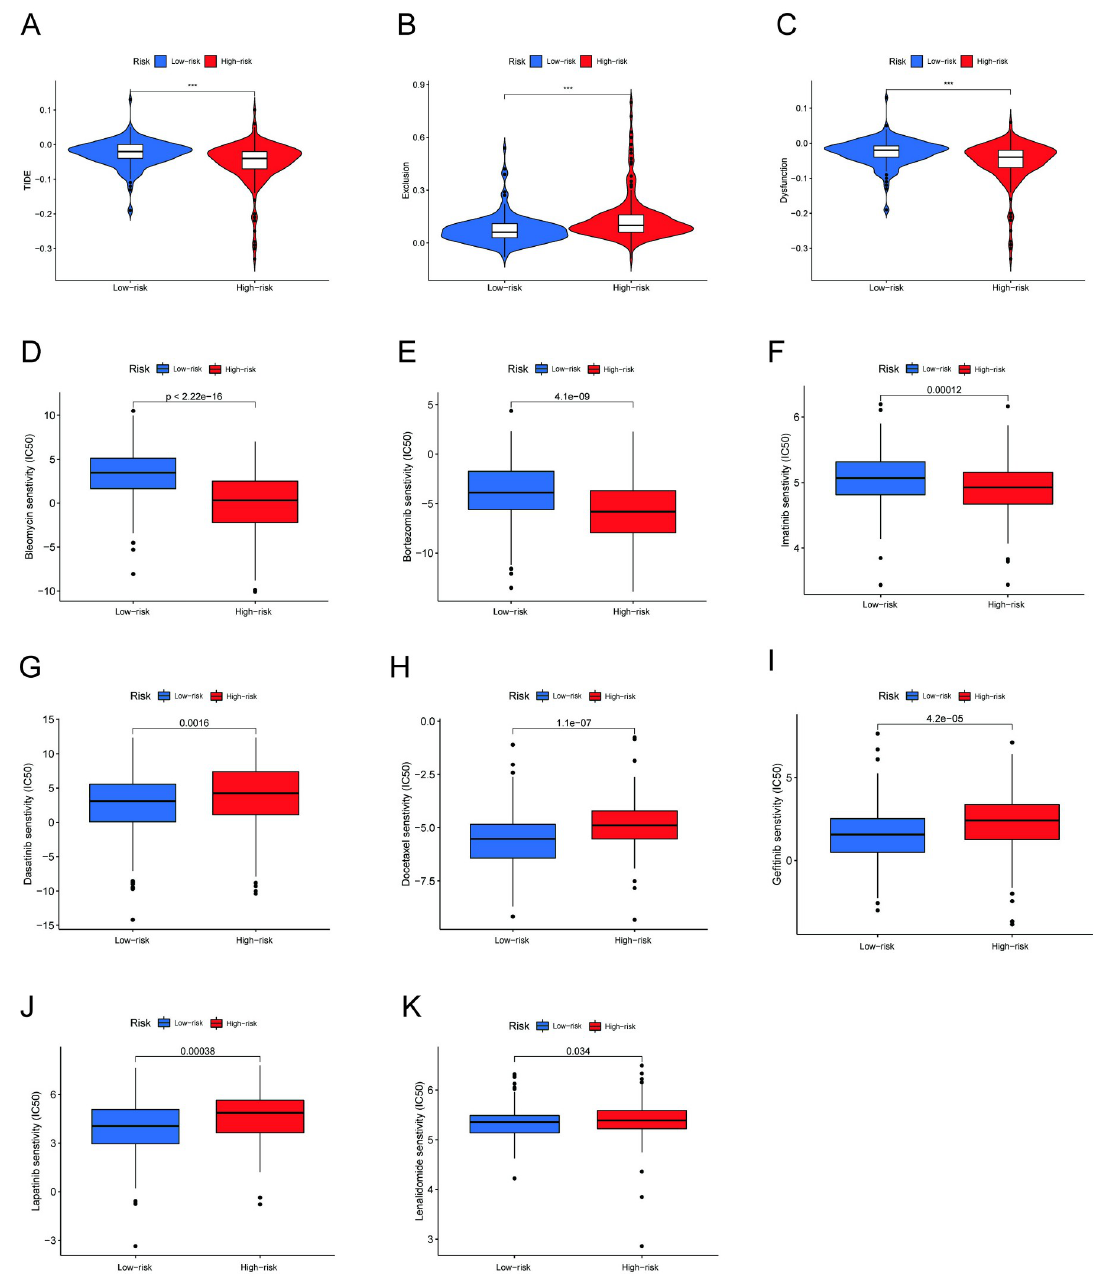
Fig 8. TIDE analysis and chemotherapy drug sensitivity in subgroups. (A-C) TIDE, T-cell exclusion and T-cell dysfunction score in different subgroups. (D-K) IC50 of common chemotherapy